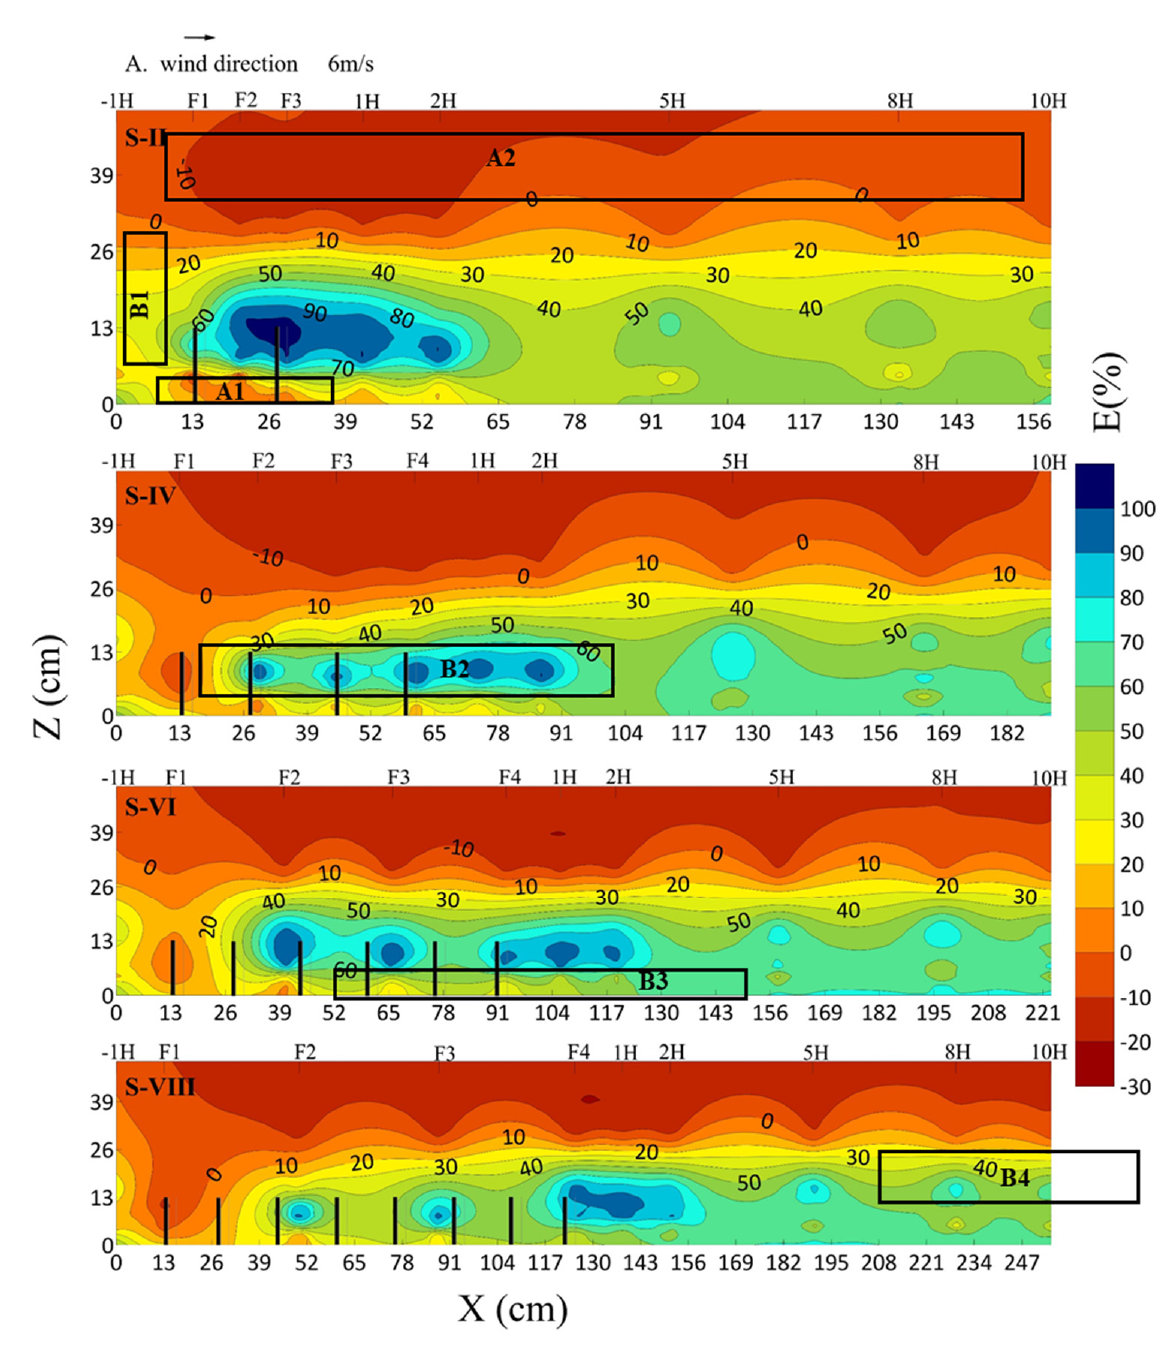
Figure 4. Contour map of the distribution of the shelter efficiency of single shelterbelts with different rows. The abscissa represents the downwind distance (cm) and the ordinate represents the vertical height (cm). The top abscissa represents the observation point. 6 m · s − 1 . The legend indicates the shelter efficiency. In addition, “ A1 , A2 ; B1 – B4 ” are, respectively, (i) local acceleration region near the ground at the leading edge of the shelterbelt ( A1 ); (ii) acceleration region above the shelterbelt ( A2 ); (iii) deceleration region in front of the shelterbelt ( B1 ); (iv) strong deceleration region in the canopy layer ( B2 ); (v) weak deceleration region behind the shelterbelt (in the trunk layer at the trailing edge of the shelterbelt and in the rear section of the shelterbelt at this height) ( B3 ); and (vi) recovery region behind the shelterbelt ( B4 ).